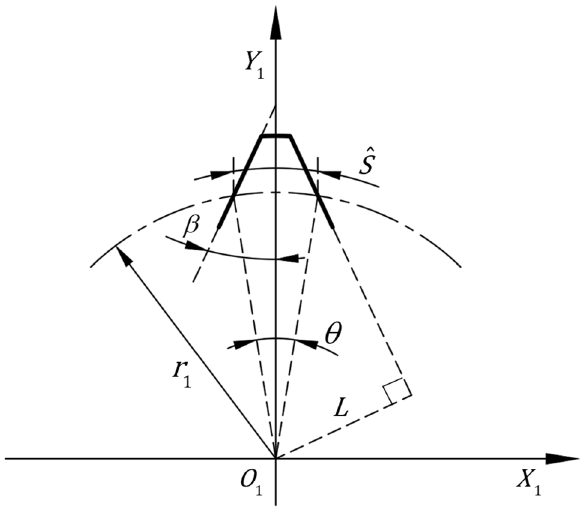
Figure 4. Geometric relations of the external gear.